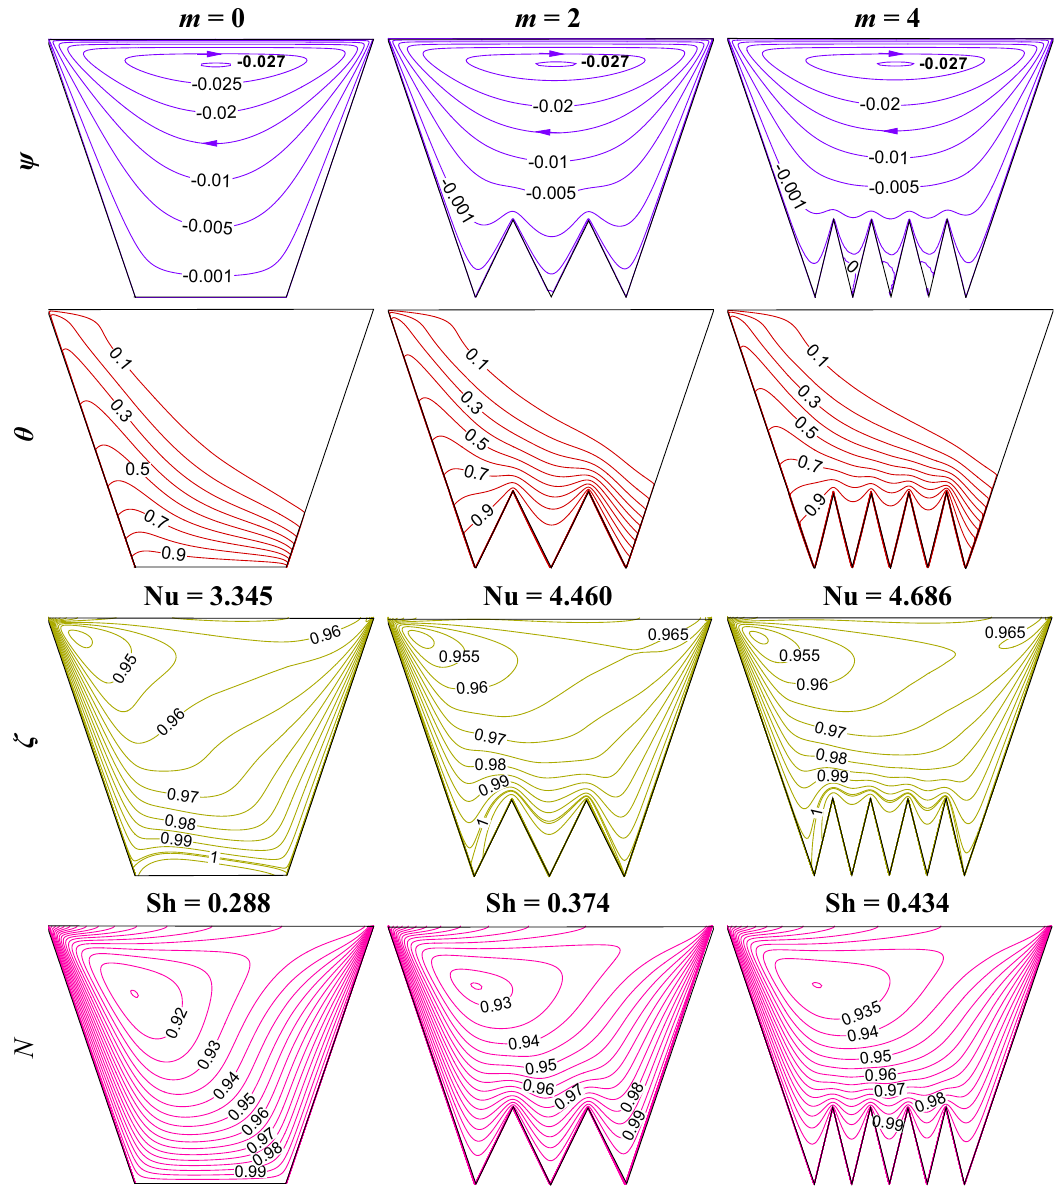
Figure 11. Streamline contours ( ψ ), Isotherms contours ( θ ), Oxygen isoconcentration ( ζ ), Microorganisms isoconcentration ( N ) for multiple triangular bottom heights ( n ) at R b = 50, Le = Pe = 1, Gr = 10 3 , Da = 10 –3 , Ha = 30, γ = 60°, and δ =